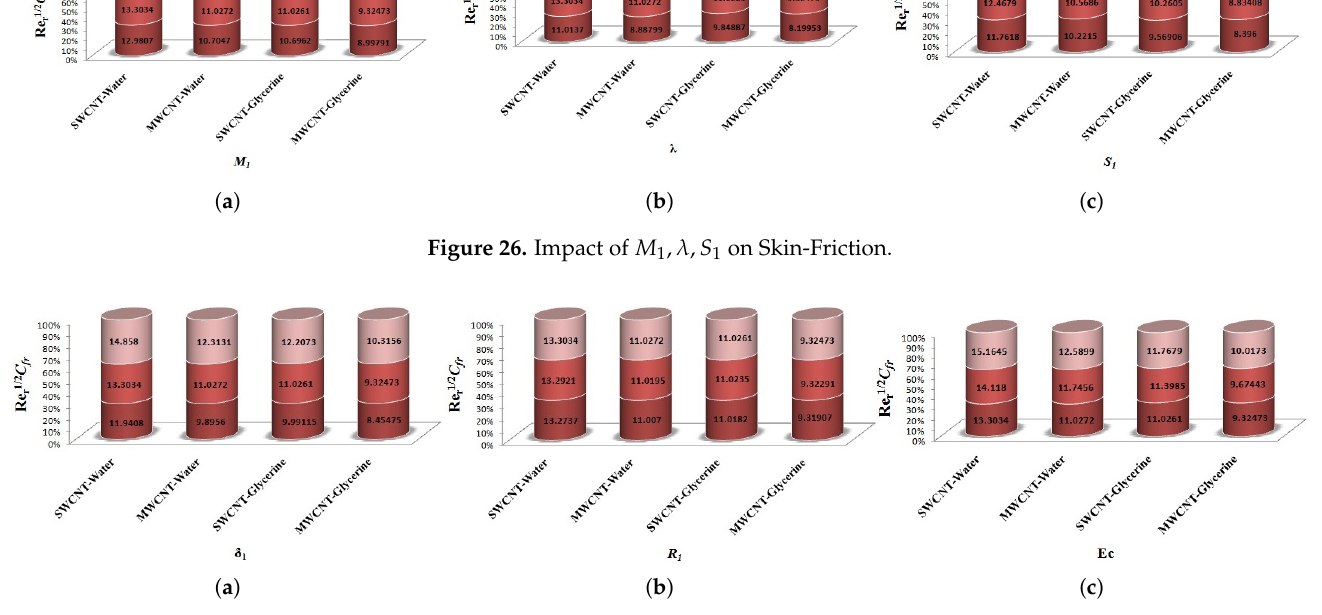
Figure 27. Impact of δ 1 , R 1 , Ec on